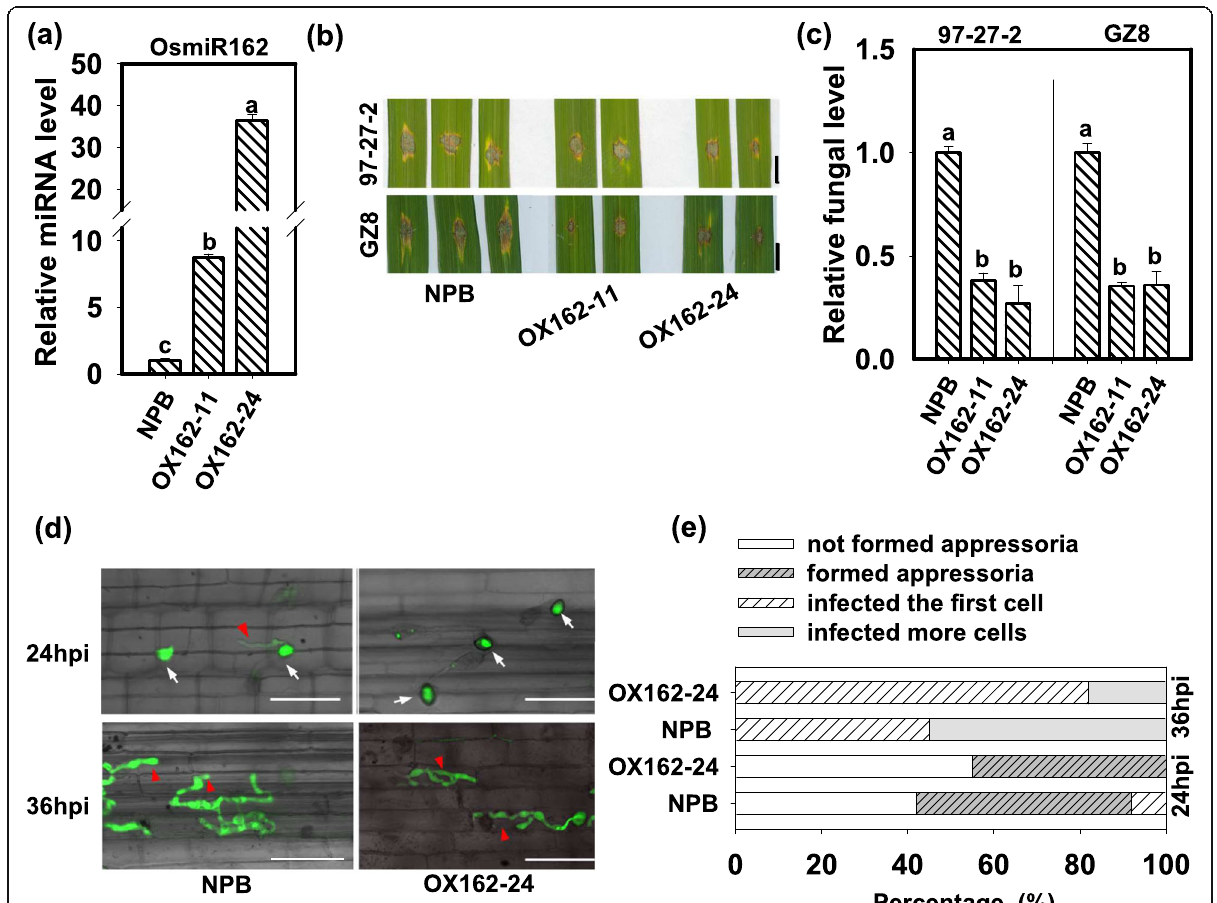
Fig. 2 Overexpression of Osa-miR162a enhances rice resistance to Magnaporthe oryzae . a Accumulation of Osa-miR162a in transgenic lines harboring 35S: Osa-miR162a (OX162). Total RNA was used to carry out reverse-transcription with an Osa-miR162 specific stem-loop RT primers (Additional file 4: Table S1), and the RT product was subsequently used as a template for quantitative polymerase chain reaction (q-PCR) to detect the amounts of Osa-miR162. snRNA U6 served as an internal reference. b Blast disease phenotypes on leaves at 5 days post-inoculation of M. oryzae strain GZ8 and 97 – 27-2, respectively. Bar = 5 mm. c Relative fungal biomass of GZ8 and 97 – 27-2 on NPB and OX162. The relative fungal biomass was measured by using the ratio of DNA level of M. oryzae Pot2 gene against the rice genomic ubiquitin DNA level. d Invasion process of M. oryzae strain GZ8 at 24 and 36 h post-inoculation (hpi) on sheath cells of indicated lines. Bars = 25 μ m. The white arrows indicate appressoria formed from conidia, and the red arrowheads indicate invasive hypha in rice sheath cells. e Quantification analysis on infection process. Over 200 conidia in each line were analyzed. For ( a ) and ( c ), Error bars indicate SD (n = 3). Different letters above the bars indicate significant differences ( P < 0.05) as determined by One-way ANOVA analysis. Similar results were obtained in at least